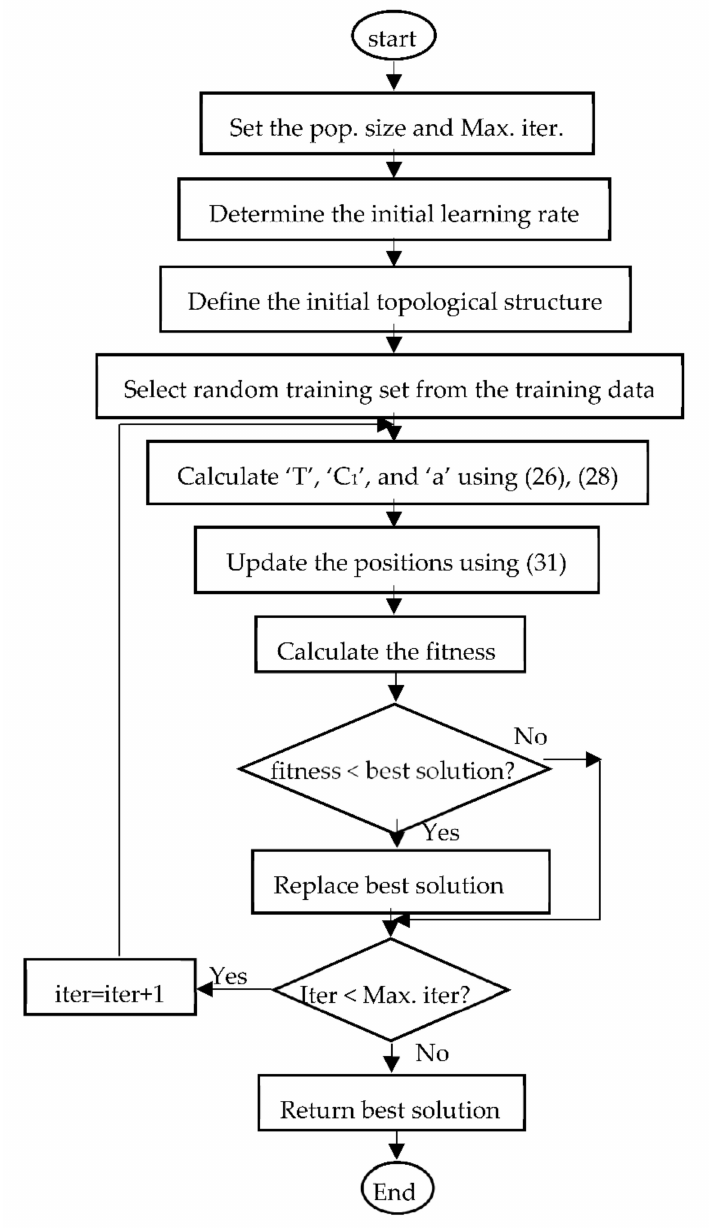
Figure 5. The flowchart of the proposed